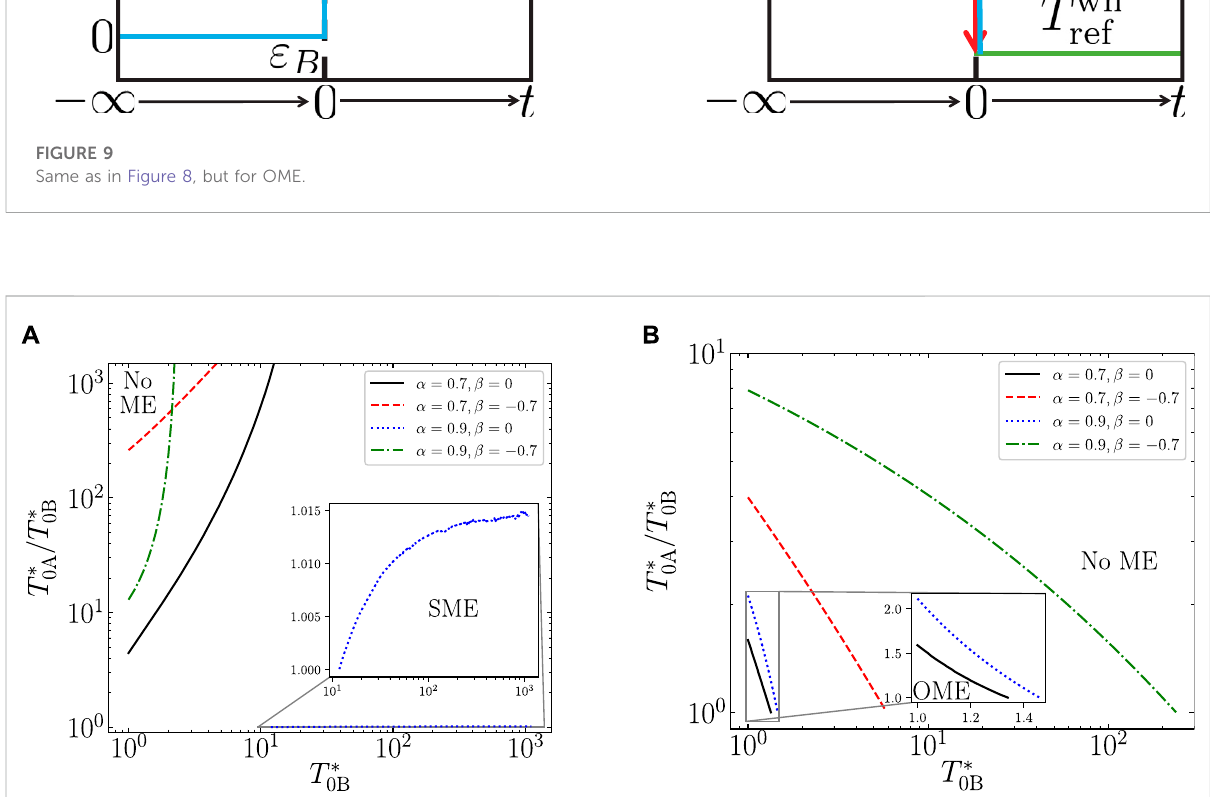
FIGURE 10 Phase diagrams intheplane T 0 A * / T 0 B * vs. T 0 B * for theemergence of (A) SME (with ε ref =0.1) and (B) OME(with ε ref =0.9).Four differentpairs ofthe coef fi cientsofrestitutionareconsidered:( α , β )=(0.7, − 0.7),(0.7,0),(0.9, − 0.7),and(0.9,0).Theinsetsshowmagni fi